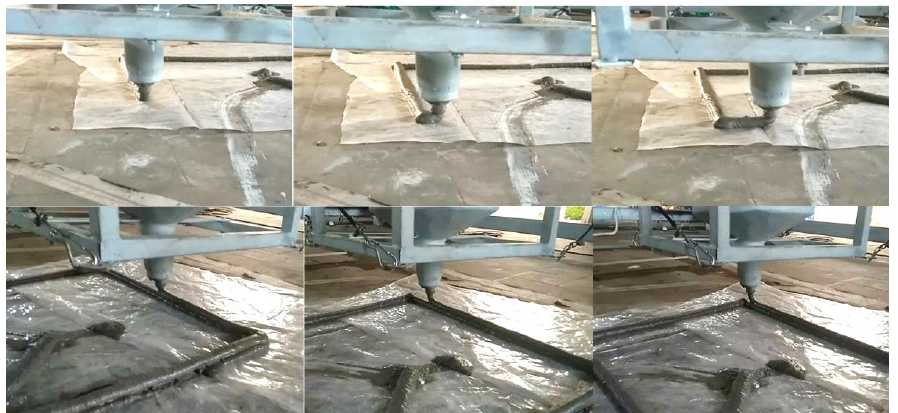
Figure 20. Result of experimental process.